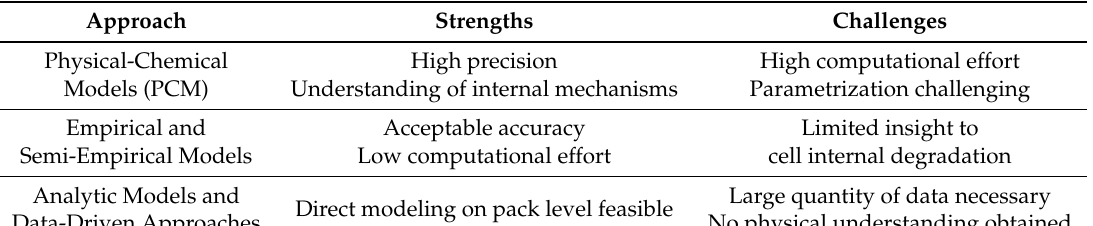
Table 4. modeling of performance and aging phenomena applicable to LIB